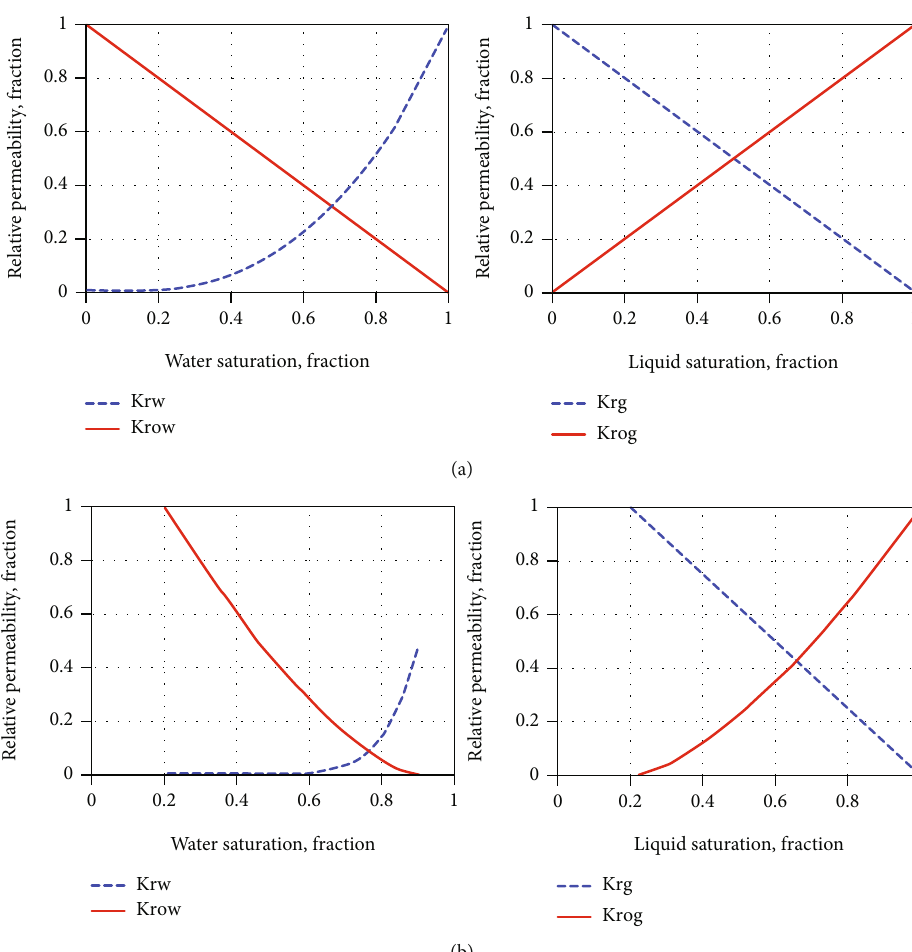
Figure 4: Three-phase relative permeability curves of: (a) fractures and (b) matrix in this study for modeling unconventional oil reservoirs.